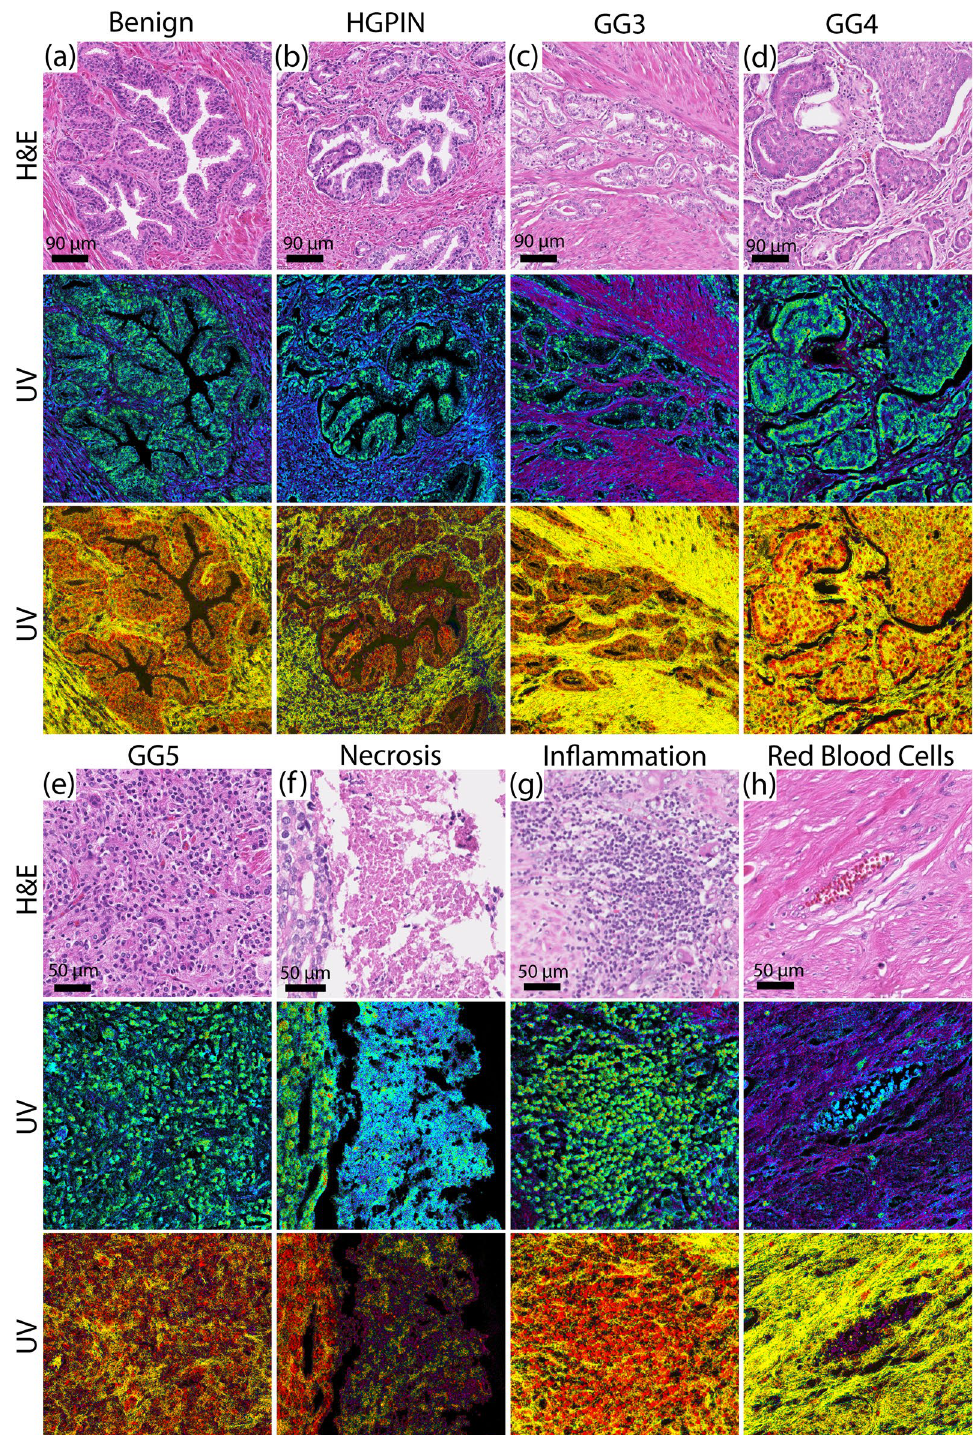
Figure 3. Comparison of the two “optical stains” with corresponding H&E-stained tissue scans from various prostate tissue structures. ( a ) Benign gland. ( b ) High grade Prostatic intraepithelial neoplasia (PIN) region. ( c ) Cancer region with Gleason Grade 3 glands. ( d ) Cancer region with Cribriform Gleason Grade 4 region. ( e ) Region with Gleason Grade 5. ( f ) Region with necrosis inside a Gleason Grade 5 cancer gland. Necrosis is clearly distinguishable from the cancer cells on the left side of the image. ( g ) Inflammation. ( h ) Red blood